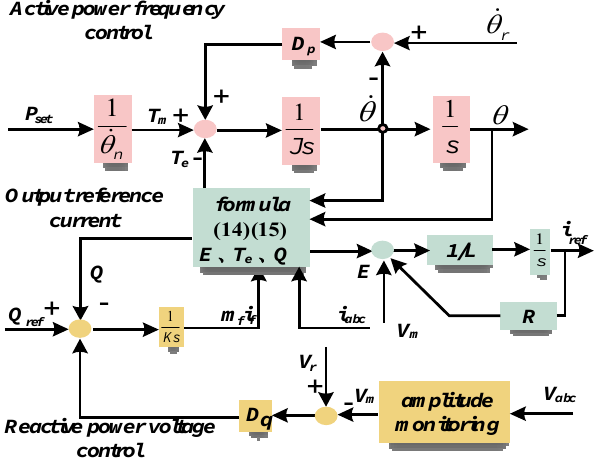
Figure 3. Virtual synchronous generator control strategy.